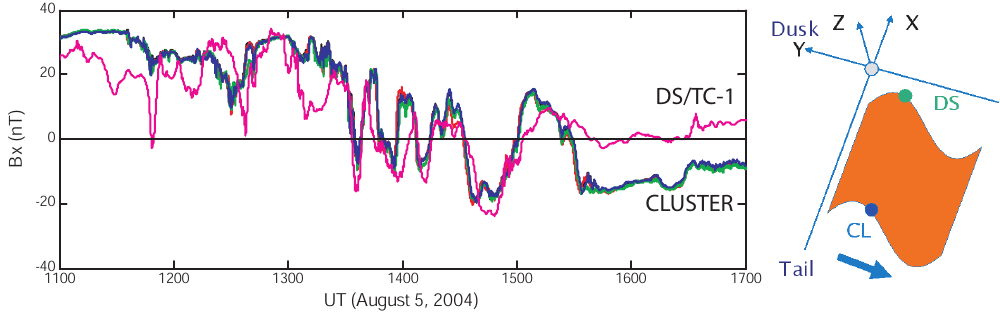
Fig. 19. Simultaneous current sheet crossings by Cluster and DS/TC-1 spacecraft, radially separated by ∼ 5 R E . (Adopted from Zhang et al., 2005).